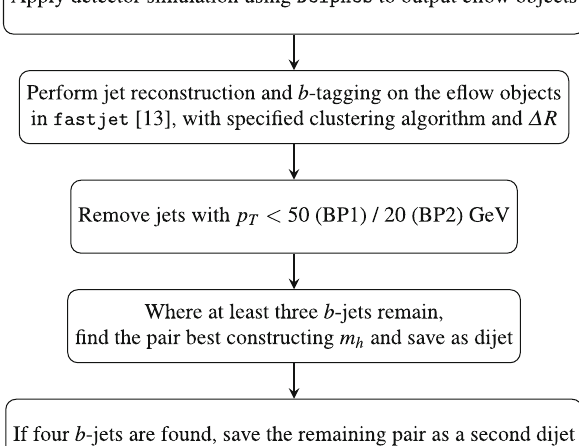
Fig. 5 Description of our initial procedure for jet clustering, b -tagging and selection of jets. Note that the bulk of our analysis is performed at particle rather than detector level, so MC truth information is used for cuts on jet constituents